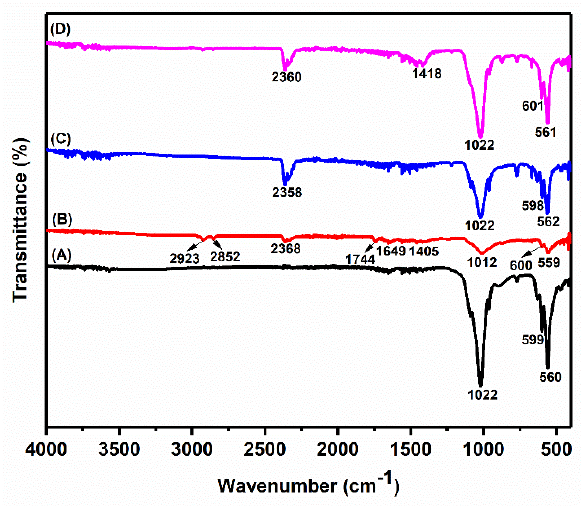
Figure 2. FT-IR spectrum of (A) Synthetic HA, (B) Raw fish bone, (C) Thermal HA, and (D) Alkali treated nano HA.